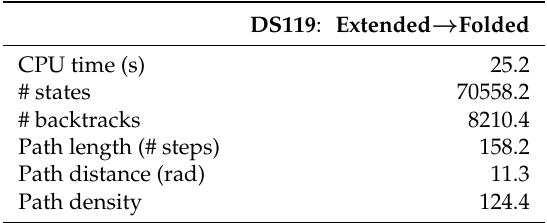
Figure 4. The left side panel represents the evolution of the structural propensities at the residue level along DS119 folding pathway. The right side panel shows some intermediate states along one of the computed folding paths. The “cartoon” representation clearly shows the formation of the helix. PyMOL [39] was used for the structural visualization. Table 3. Performance indicators of the HDFS algorithm on